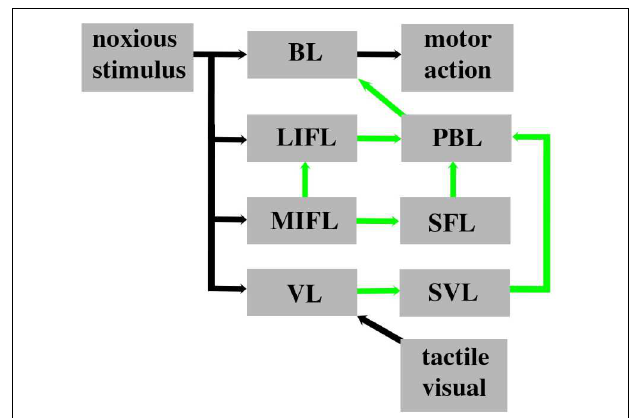
FIGURE 7 | Octopus brain circuitry underlying processing of noxious stimuli based on Young (1991). The circuitry as described in Figure 2 is schematized here to fit the parallel forward models algorithm. The circuitry can be compared with the human cortical circuitry presented in Figure 6 . Noxious information is relayed in parallel to the brachial lobe (BL), lateral inferior frontal lobe (LIFL), medial inferior frontal lobe (MIFL), and the vertical lobe (VL). The VL feeds forward to the subvertical lobe (SVL). The MIFL feeds forward to the subfrontal lobe (SFL) and the LIFL. The SVL, SFL, and LIFL all feed forward to the posterior buccal lobe (PBL) which then feeds forward to the brachial lobe. The brachial lobe controls motor actions. The VL also receives input from the tactile and visual